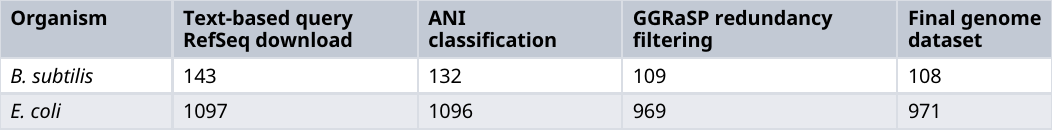
Table 1. Number of B. subtilis and E. coli genomes selected after each genome filtering step.